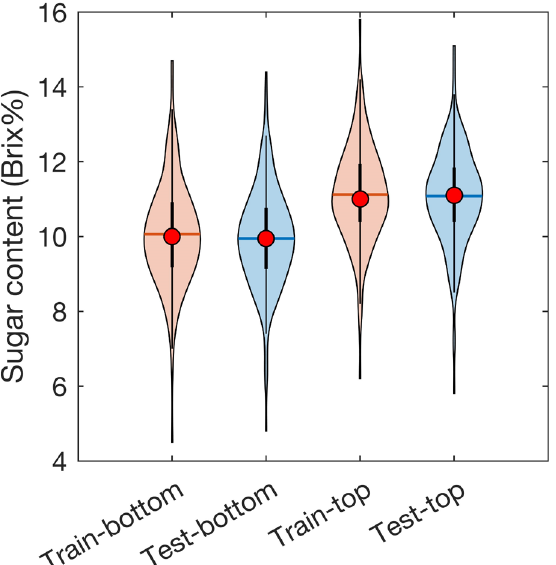
Figure 8. Sugar content (Brix%) references measured from blocks cut from the top and bottom of the fruit using a Brix meter (training dataset vs. testing dataset).